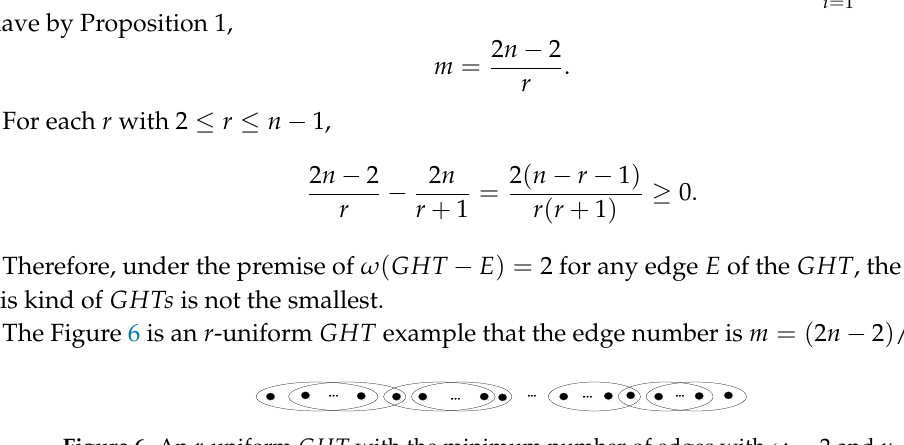
Figure 6. An r -uniform GHT with the minimum number of edges with ω = 2 and u = 2 .